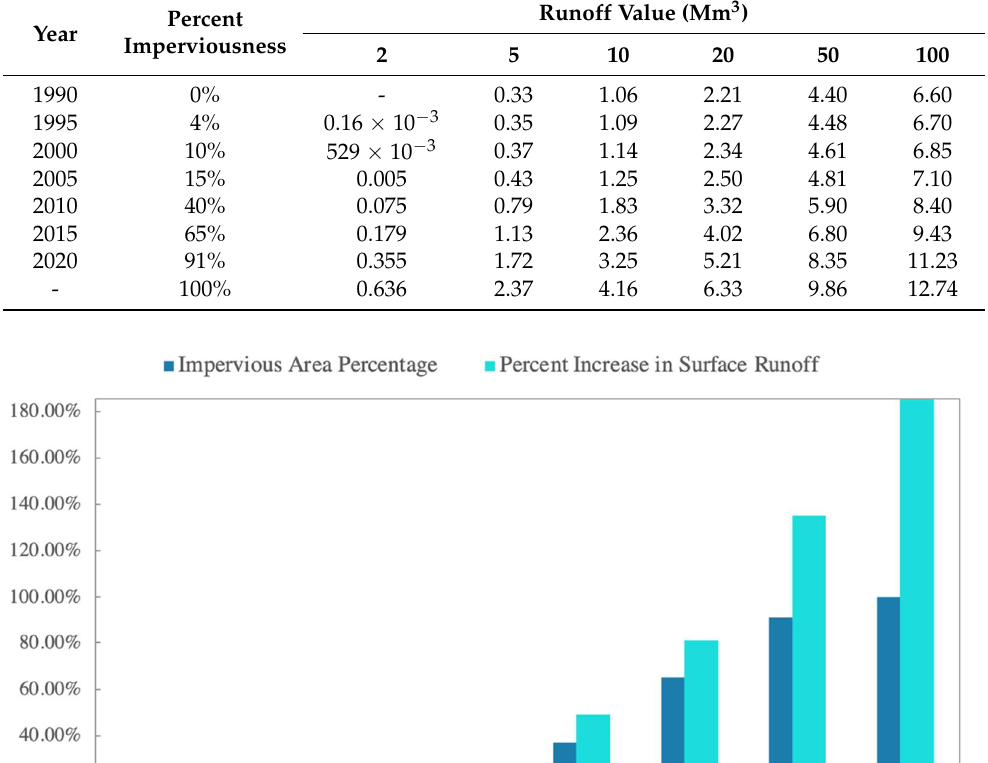
Table 5. Runoff values for New Cairo at different urbanization level percentages correspond to six return period storms.